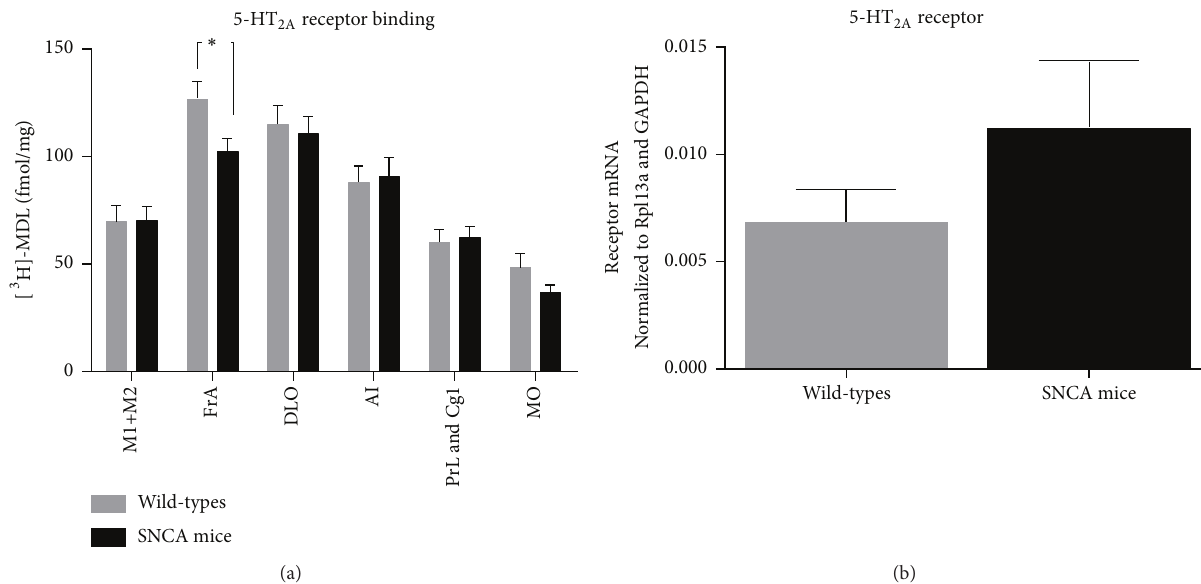
Figure 2: 5 -HT 2 A receptor mouse prefrontal cortex autoradiography binding analysis and gene expression levels. (a) Results from [ 3 H] MDL 100.907 ( 5 -HT 2 A ) binding. FrA [ 3 H] MDL 100.907 binding is significantly lower in alpha-synuclein overexpressing (SNCA) mice compared to wt mice. Bars: grey: wild-type mice ( 𝑛 = 9 ); black: SNCA mice ( 𝑛 = 10 ). ∗ 𝑝 < 0.05 . Multiple 𝑡 -test. Data illustrated with mean ± SEM. (b) Results from RT-qPCR show CT ratios (calculated using CT-ratio (receptor/reference) = 2 ( CT ( reference ) − CT ( receptor )) ) comparing alpha- synuclein overexpressing (SNCA) and wt mice. Reference genes are Rpl13a and GAPDH. No difference in receptor gene expression was found. Bars show mean ±